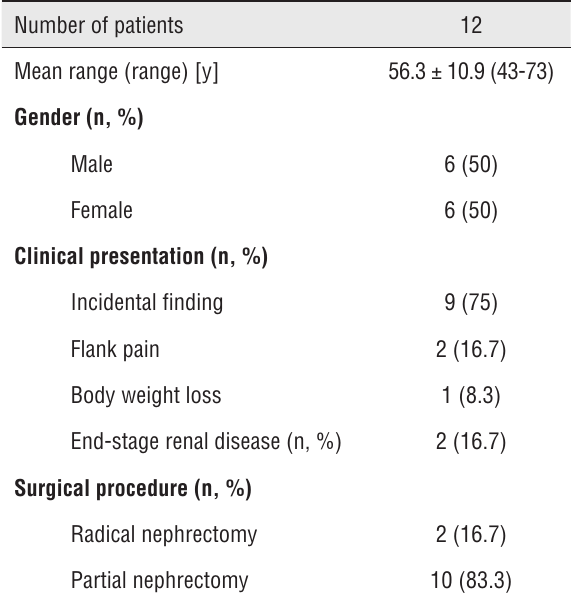
Table 1 - Clinical characteristics.